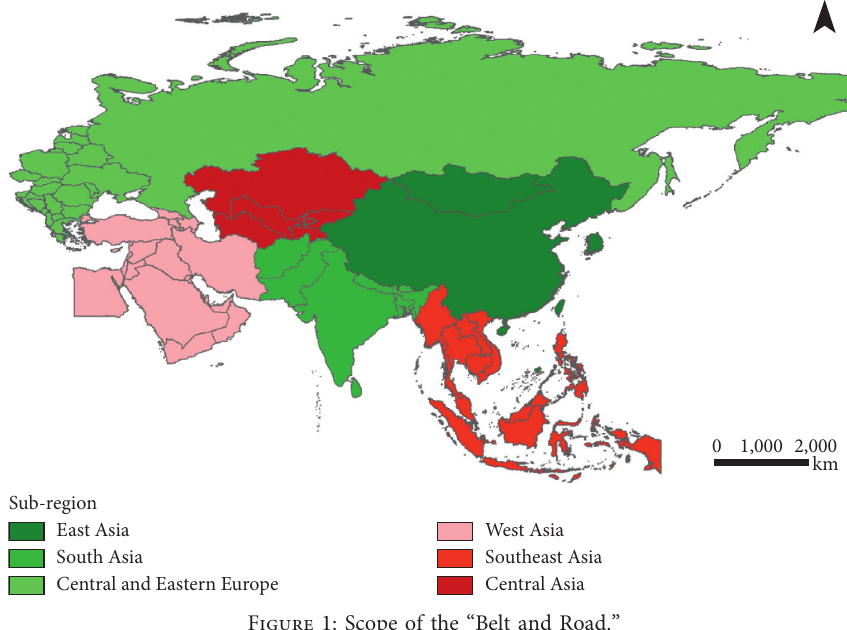
Figure 1: Scope of the “Belt and